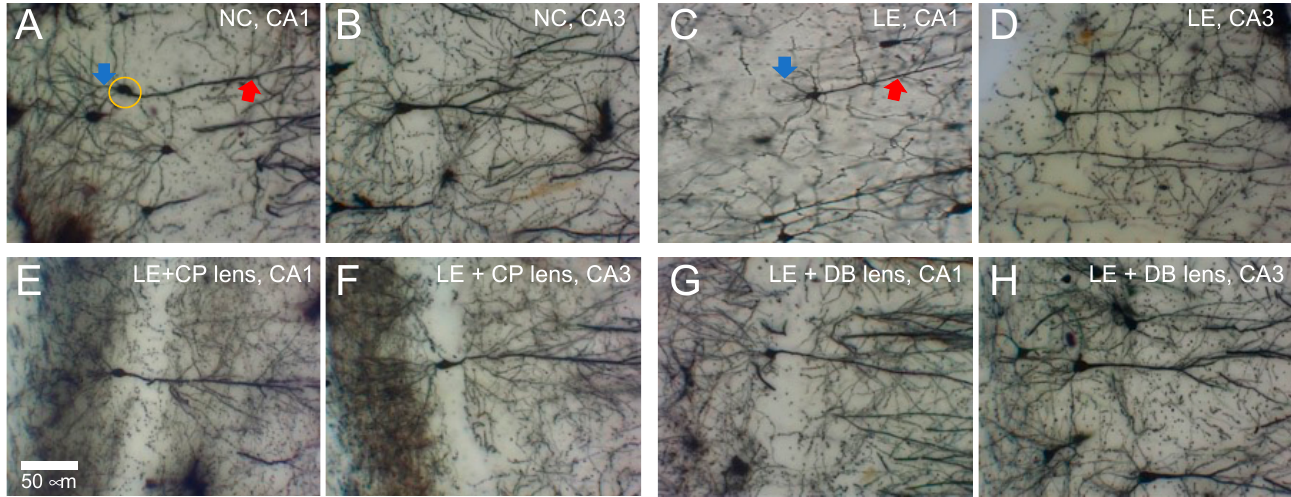
Figure 2. Representative micrographs of Golgi–Cox-stained CA1 and CA3 neurons. ( A ) Normal Control, NC (CA1) apical (red arrow) and basal dendrites (blue arrow) are indicated along with the soma (orange circle). ( B ) NC (CA3). ( C ) Light exposure, LE (CA1). ( D ) LE (CA3). ( E ) Light exposure with the CP lens (CA1). ( F ) LE + CP (CA3). ( G ) Light exposure with the DB lens (CA1). ( H ) LE + DB (CA3).